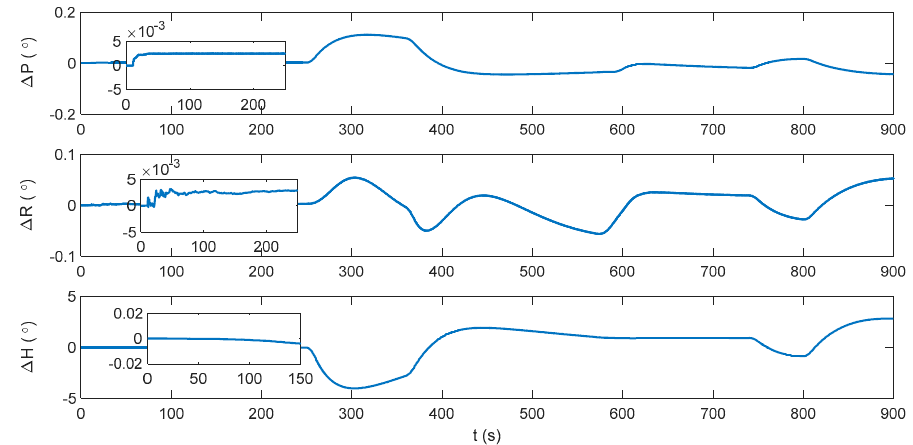
Figure 6. Attitude error of the INS/zero velocity update (ZUPT) solution. Sensors 2017 , 17 , 2030